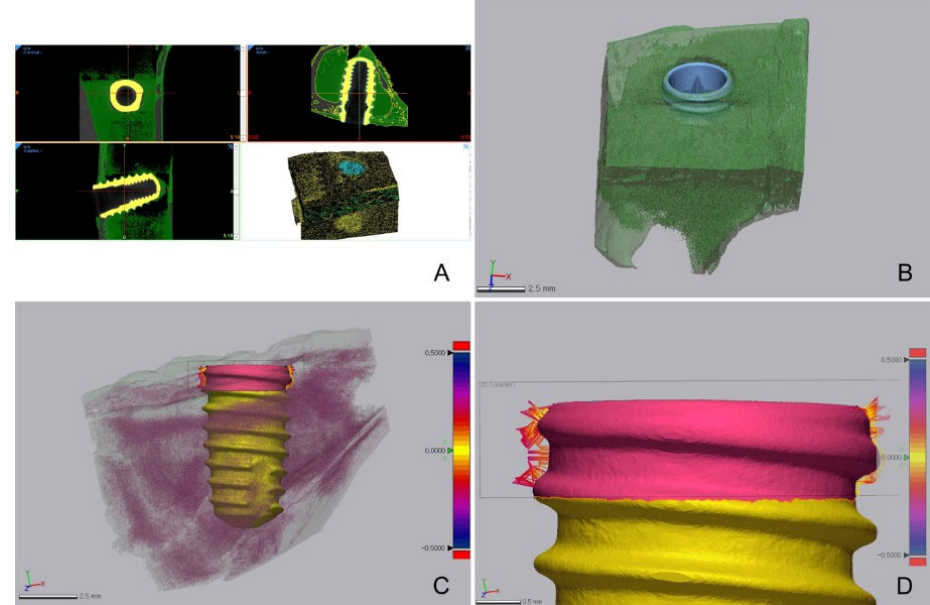
Figure 5. Procedure for analyzing the bone-implant-contact (BIC). ( A ) Segmentation of the implant and bone tissue. ( B ) Segmented implant and bone tissue. ( C , D ) BIC analysis in the cortical bone area. Pink indicates cortical bone, while yellow indicates cancellous bone (from yellow to purple, the distance is farther).